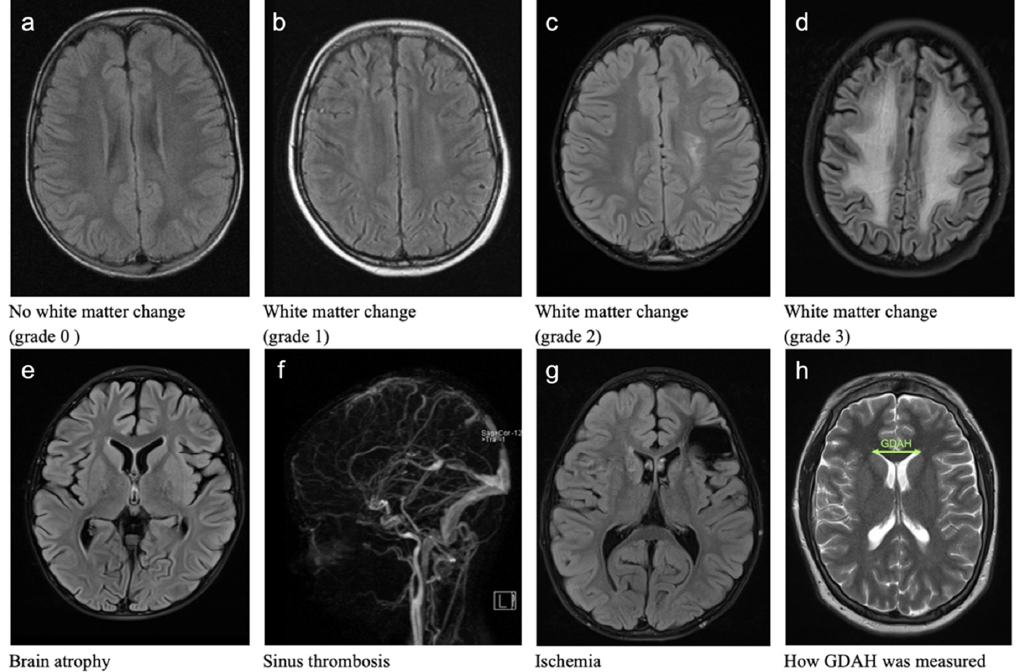
Figure 1. CMRI axial: Examples of different pathomorphologies and how GDAH was